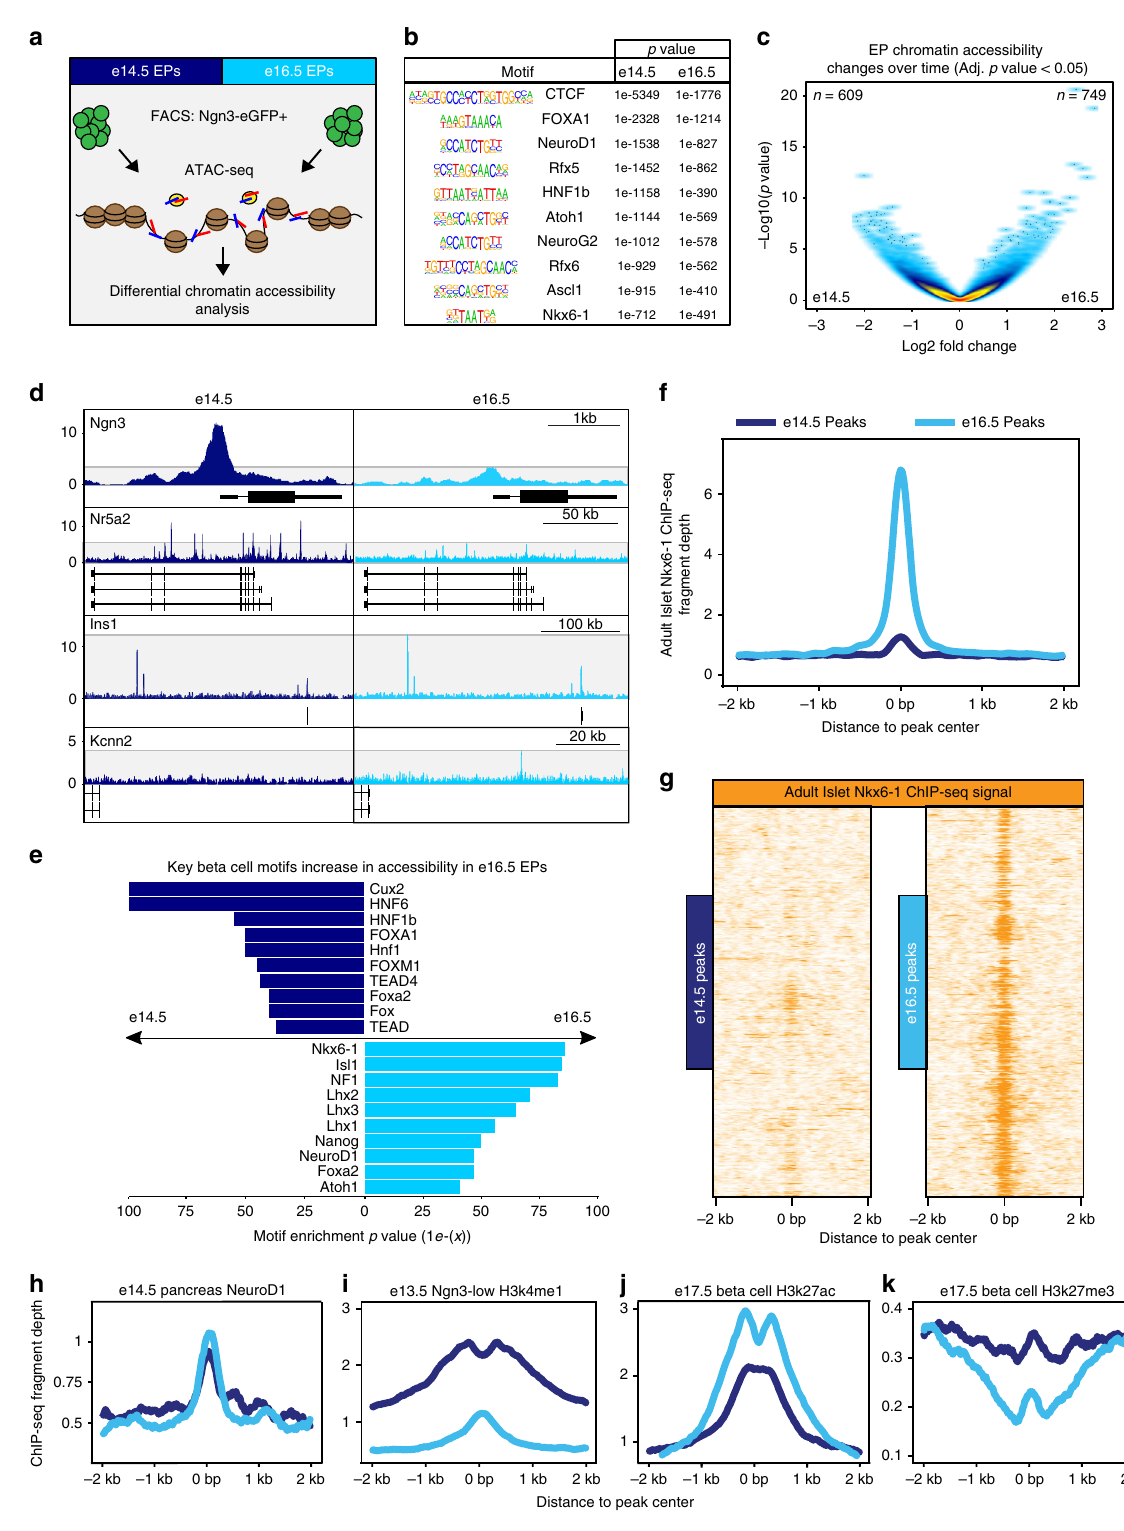
BPs (Fig. 7a; average cluster expression). Thus, we analyzed the epithelium that gives rise to EPs to see if changes were occurring prior to Ngn3 expression, as the epithelium is remodeling from a plexus to an arborized ductal system throughout these stages (Fig. 7b). STAMP-ID tracing of the earliest e14.5 and e16.5 EP subtypes showed that both BPs and tip cells contribute to the EP pool. Interestingly, tip cells made up 16% of the earliest e14.5 NATURE COMMUNICATIONS| (2018) 9:3356 |DOI: